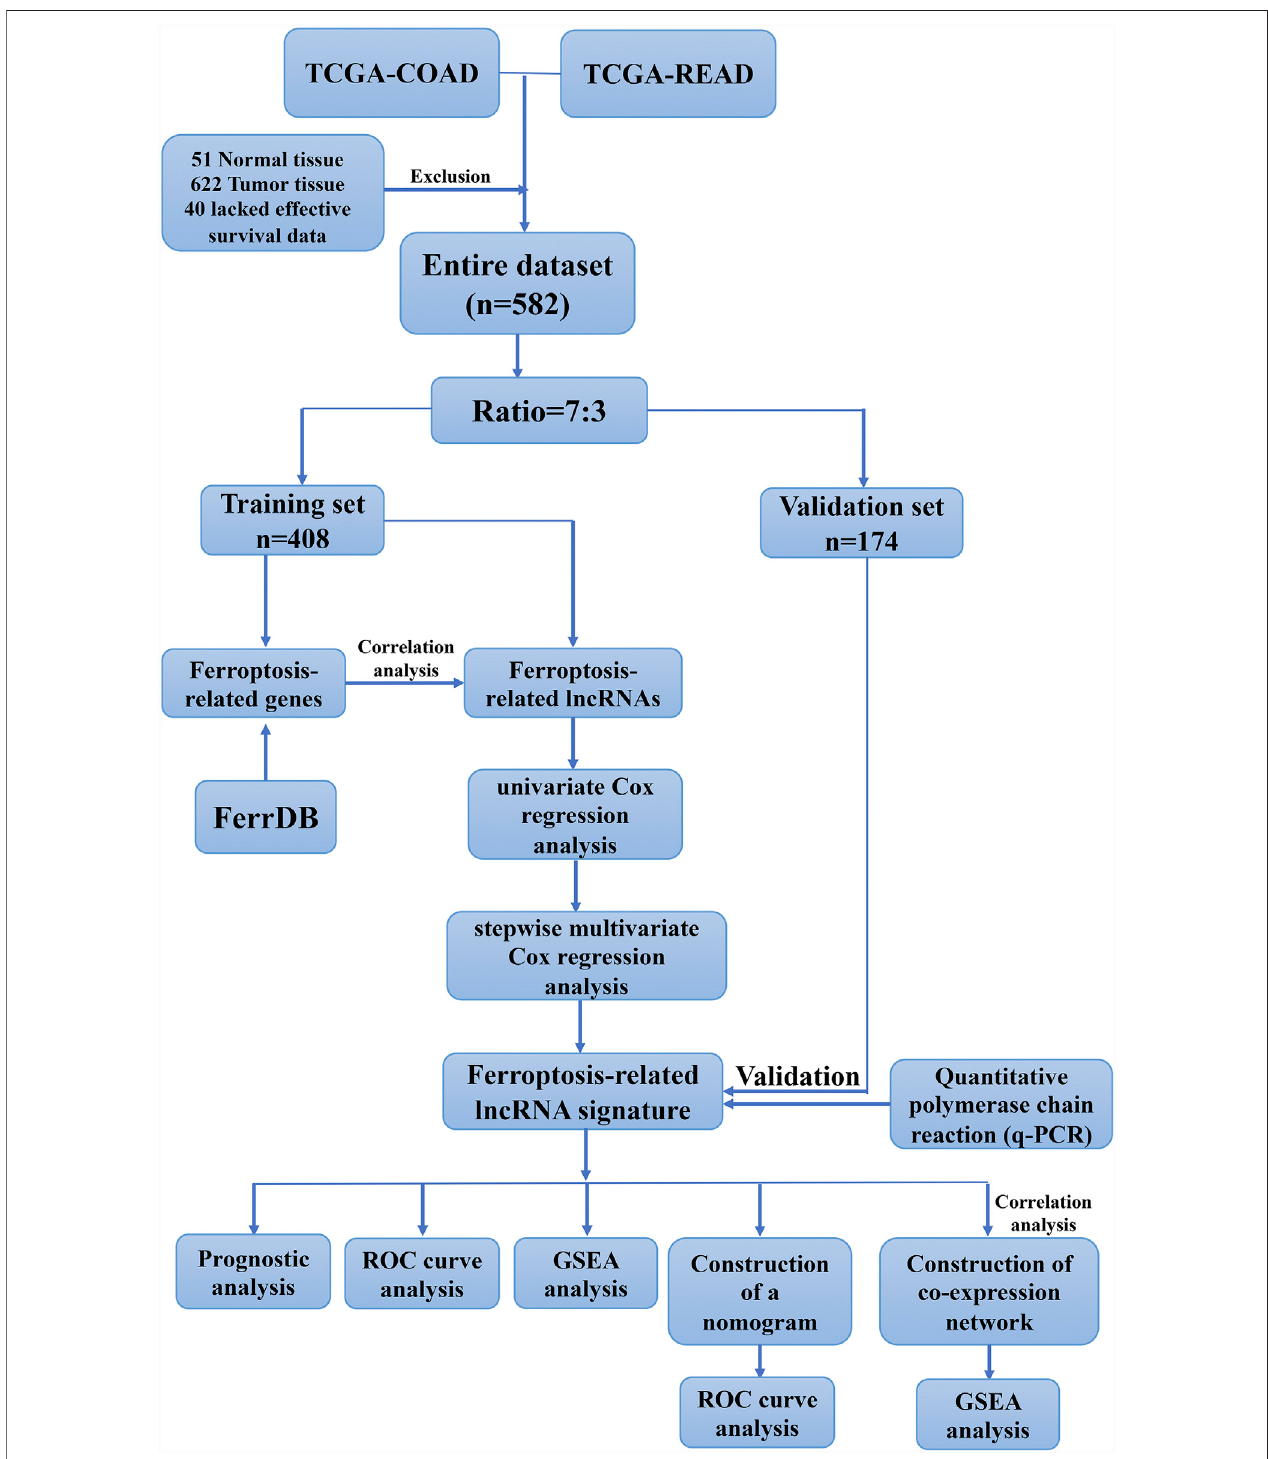
FIGURE 1 | Work fl ow for the construction of a risk signature in colorectal cancer.